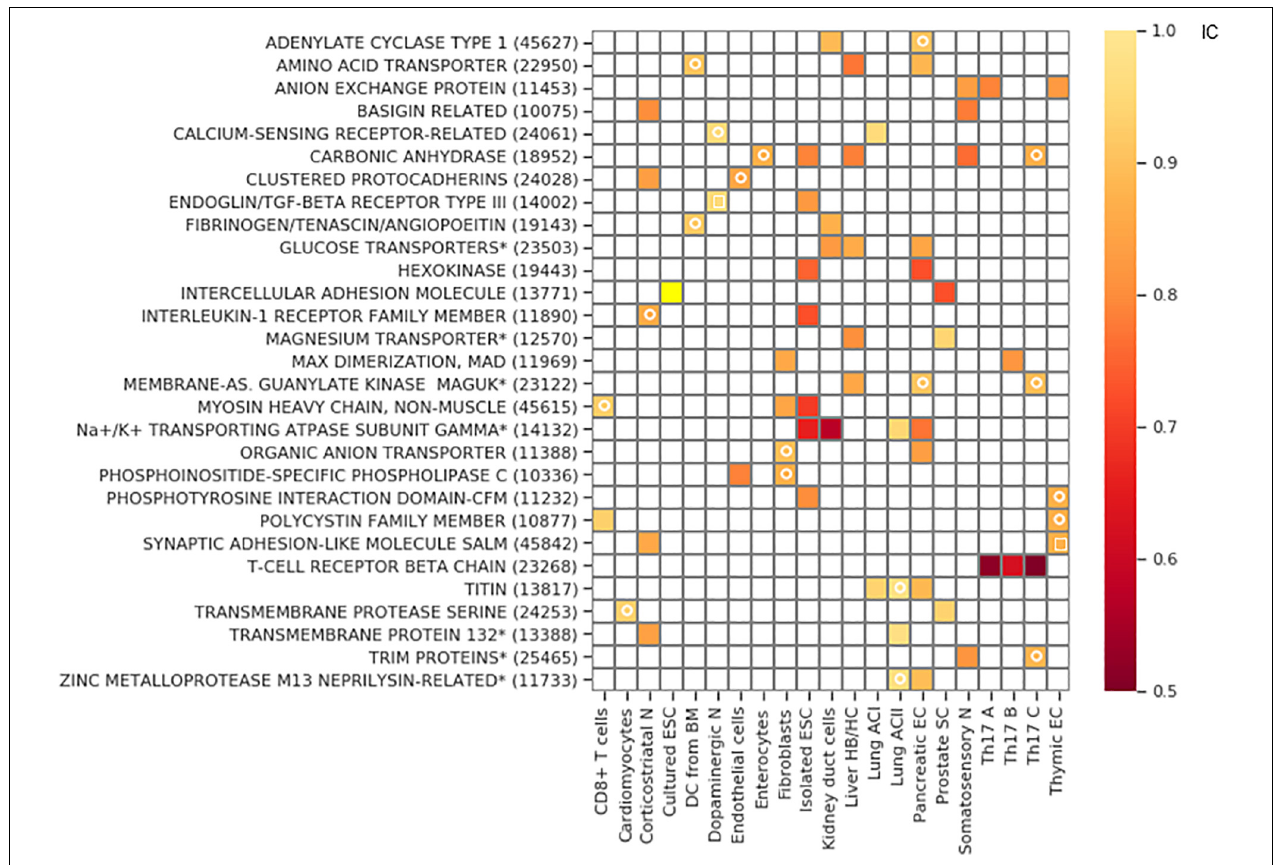
FIGURE 7 | Gene families with exclusive gene choice. Gene families with stochastic exclusive gene choice in two or more cell types; further details of selection as in Supplementary Figure 5 (see also Supplementary Data 1 ). For the families labeled with star, descriptive names were given instead of the Panther names. The Panther numbers of the families are indicated in parenthesis. The white circle denotes segments with an IC numerically less than 1 without reaching significance. The white empty squares indicates the families that lose exclusivity after truncation of the cell population at the 10th percentile of the total number of detected genes per